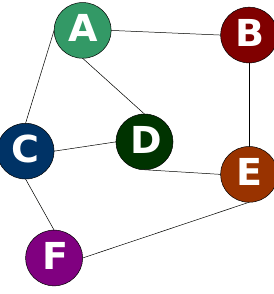
Figure 8. Heterogeneous SDN doms.